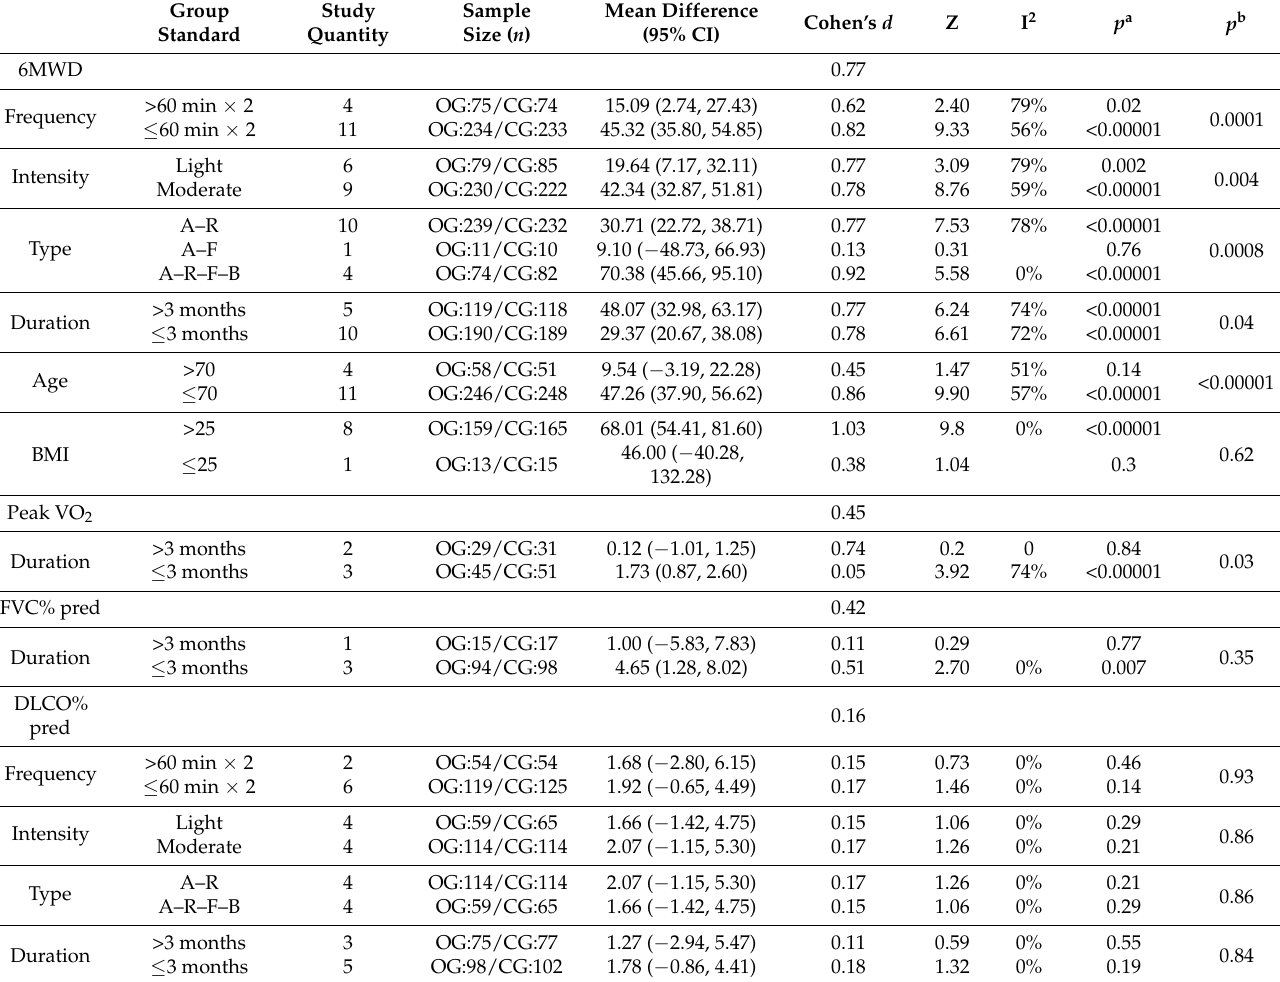
Figure 2. 6MWD. Figure 2. 6MWD. Table 3. Subgroup analysis Table 2. Characteristics of the included studies.